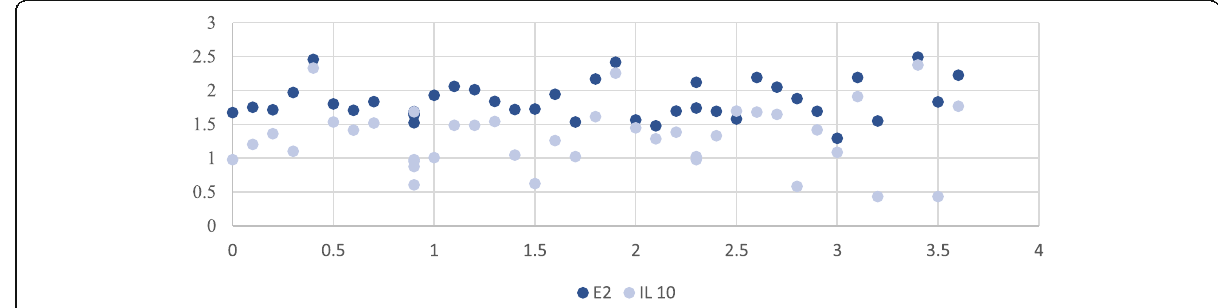
Fig. 1 Correlation between estrogen levels and interleukin 10 (IL-10) levels in